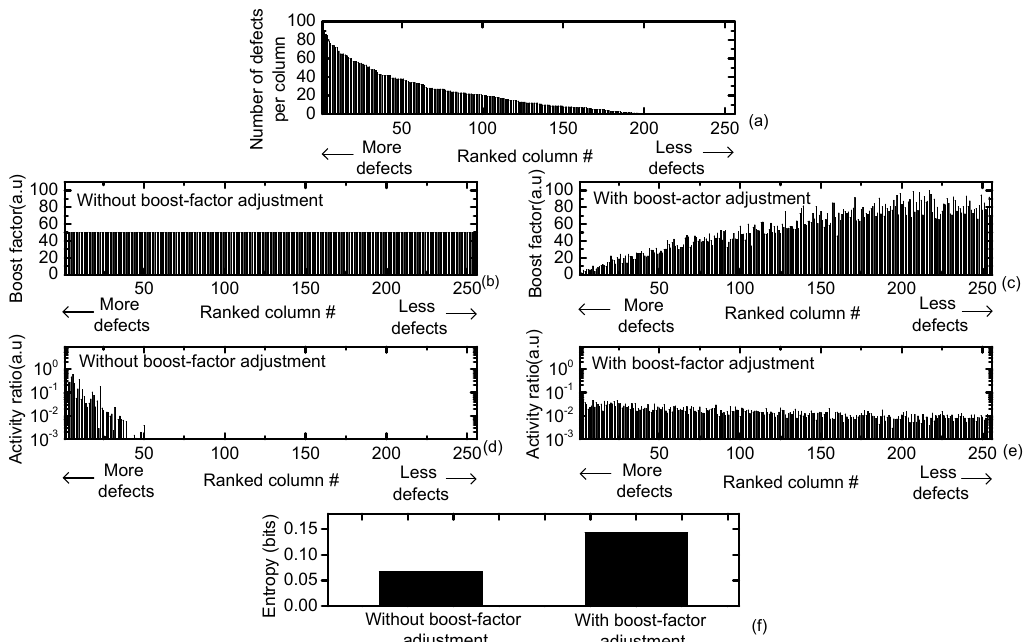
Figure 5. ( a ) The number of defects per column ranked from largest (left) to smallest (right); ( b ) the simulated boost factor of the crossbar without the boost-factor adjustment; ( c ) the simulated boost factor of the crossbar with the boost-factor adjustment; ( d ) the simulated activity ratio of the crossbar without the boost-factor adjustment; ( e ) the simulated activity ratio of the crossbar with the boost-factor adjustment; and ( f ) the comparison of crossbar entropy without and with the boost-factor adjustment.